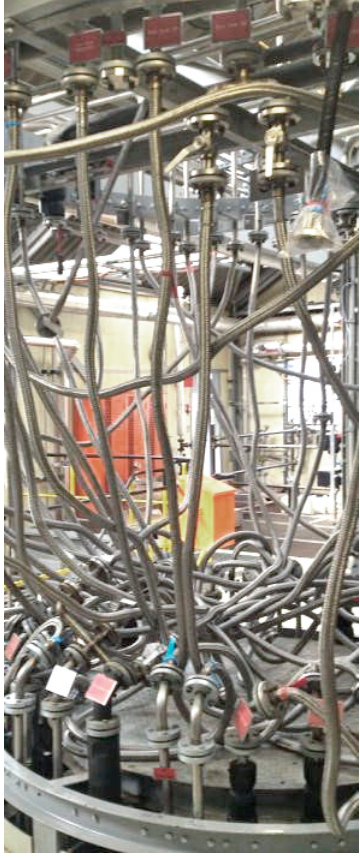
Figure 2. Flexible hoses as interconnections between fixed equipment piping in a multi-purpose-plant coupling station of Lonza AG.